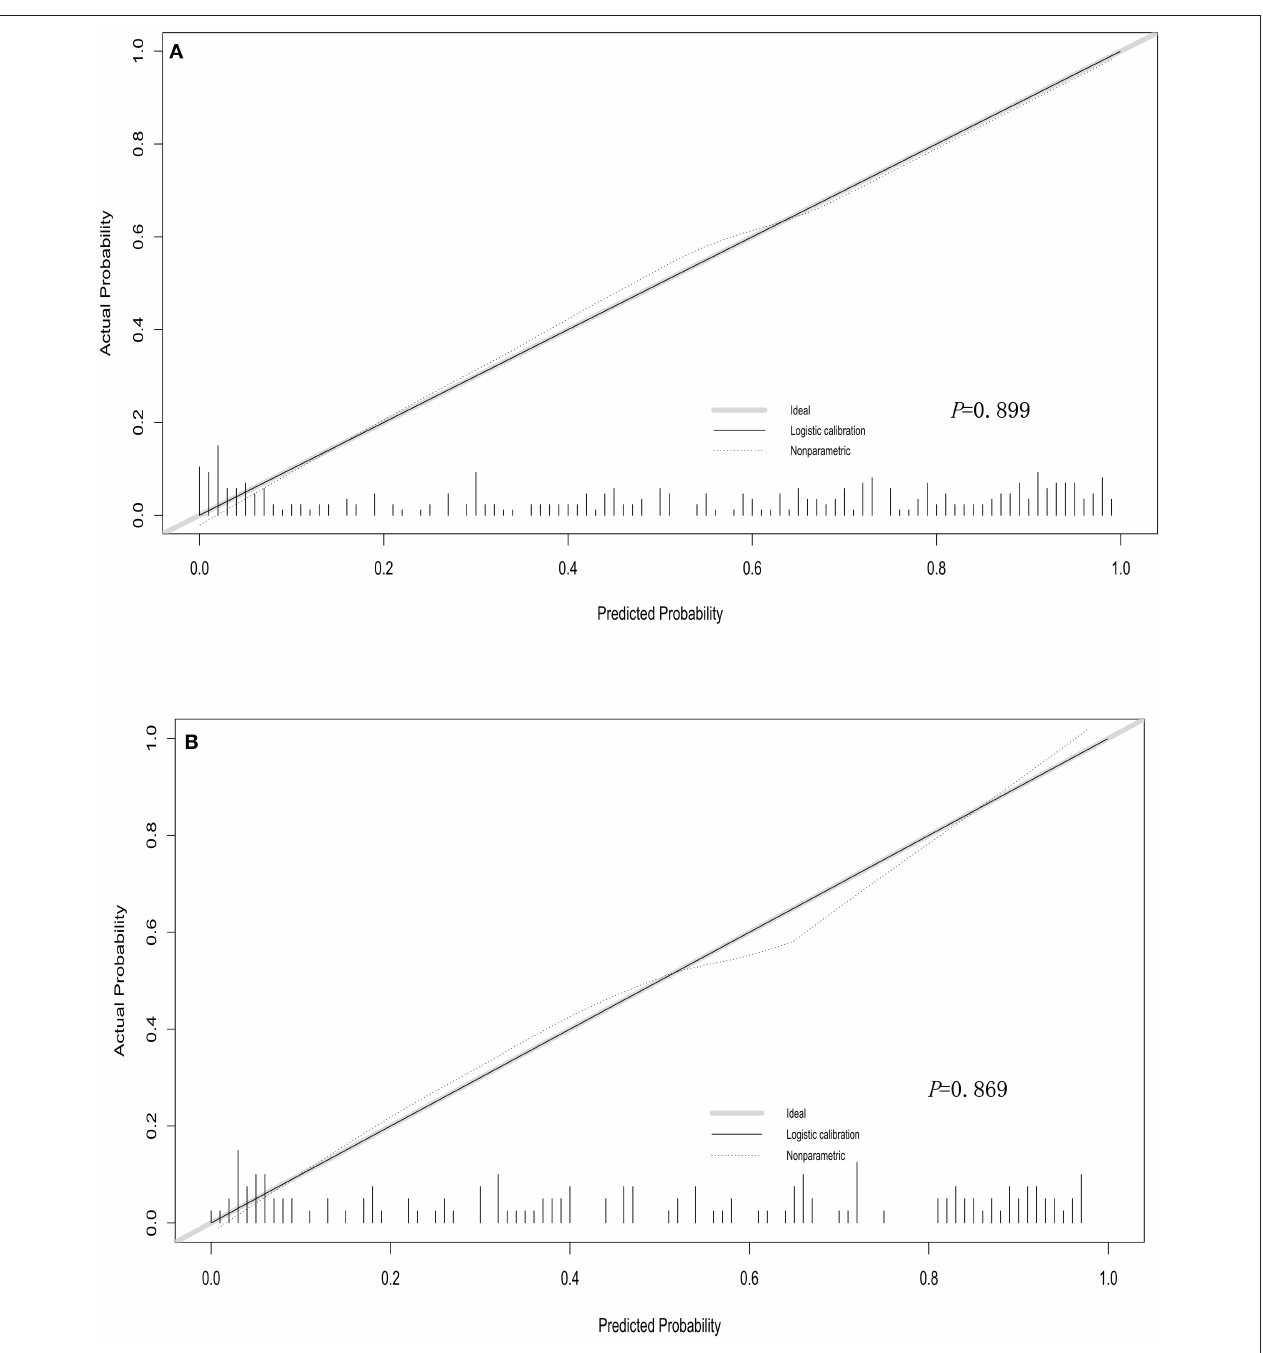
FIGURE 2 | Calibration curves of the nomogram in training cohorts (A) and validation cohorts (B) . The calibration curve predicts the risk of RMPP in the queue. The x-axis represented the projected risk of RMPP. The y-axis represented the RMPP of the actual diagnosis. The diagonal dotted line represented the perfect prediction of the ideal model. The solid line represented the performance of the line chart, which is closer to the diagonal dashed line to indicate a better prediction. color Doppler echocardiography revealed multiple masses in discovered that MP infection was independently associated with the right ventricle. Spiral CT pulmonary angiography showed a the risk of developing subsequent ischemic stroke in over 1,000 filling defect in the left lower pulmonary artery and a nodular patients with MP infection (37). In our RMPP group, one filling defect in the right ventricle. Right ventricle thrombosis child with severe RMPP was monitored on the eighth day of and left lower pulmonary thromboembolism were disease onset with D-dimer levels increased to 13 mg/L, and